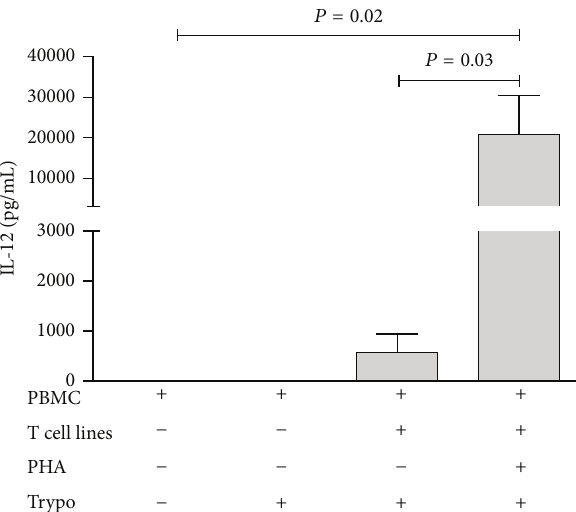
Figure 2: T. cruzi -induced IL-12 production is potentiated by activated T cells. Results come from 4 distinct experiments. Groups were compared by a nonparametrical test (Mann-Whitney Rank Sum Test) with GraphPad InStat software (version 5.0; GraphPad). Results were expressed as medians and interquartile ranges. 𝑃 values were considered significant if <